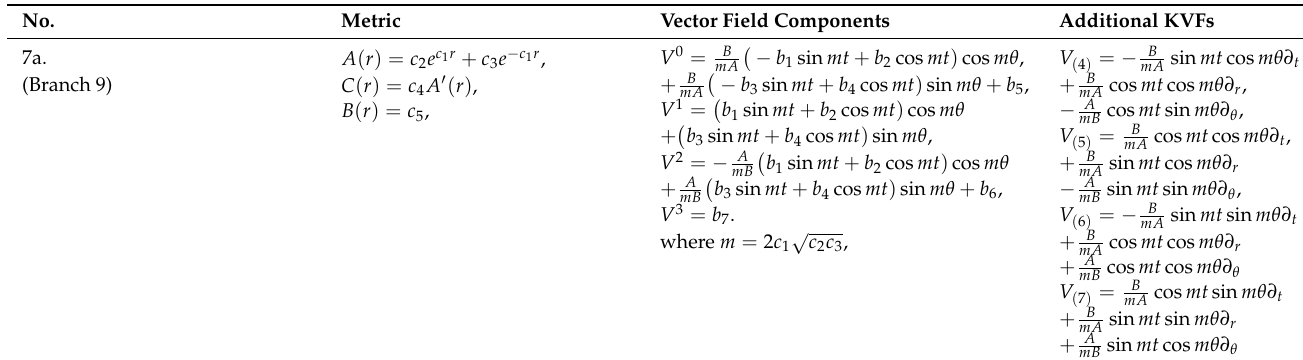
Table 3. Metrics admitting seven KVFs.